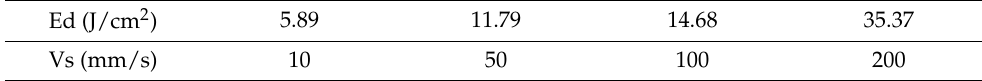
Table 2. Laser texturing